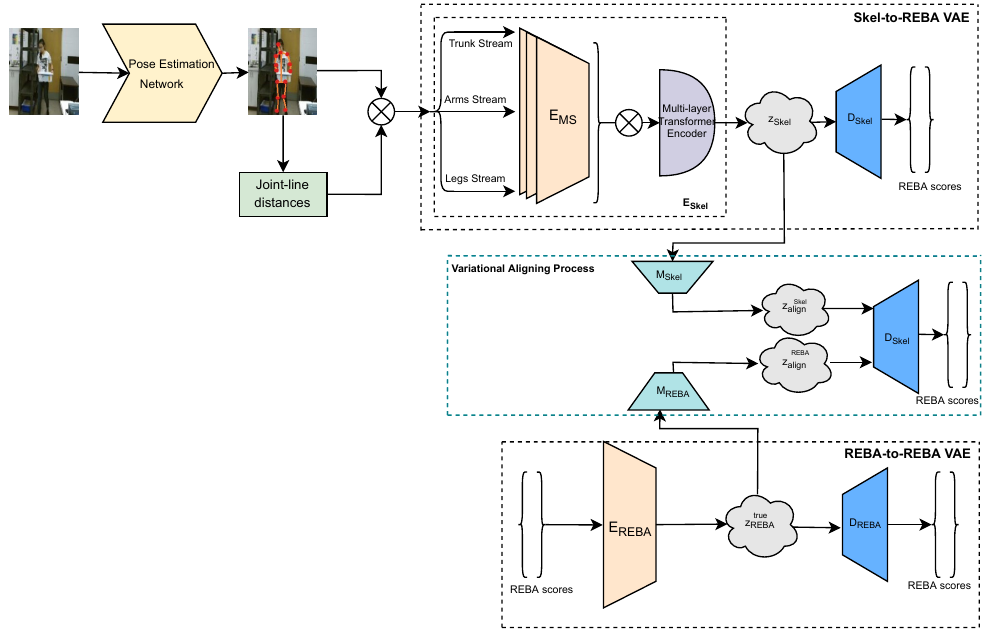
Figure 1. An overview of the proposed variational framework. Given an input image, 3D pose information is extracted from any human pose estimation algorithm and fed into a multi-stream encoder and a multi-layer Transformer encoder to model local and global joint interactions and generate the skeletal latent space. A second variational branch is employed to derive the true posterior distribution of REBA scores. Finally, the variational aligning process aims to bring the computed skeletal latent space closer to the one related to the ground truth REBA scores, enhancing the discrimination ability of the skeletal latent space and improving the ergonomic risk assessment results. The operator ⊗ denotes